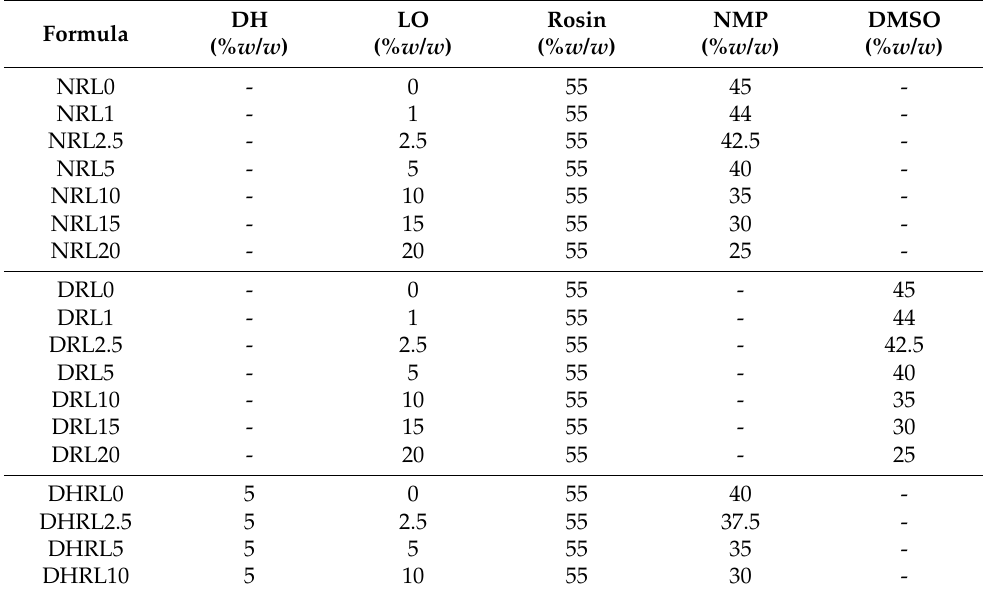
Table 4. The composition of drug-free and DH-loaded in situ forming gel formulations with different LO